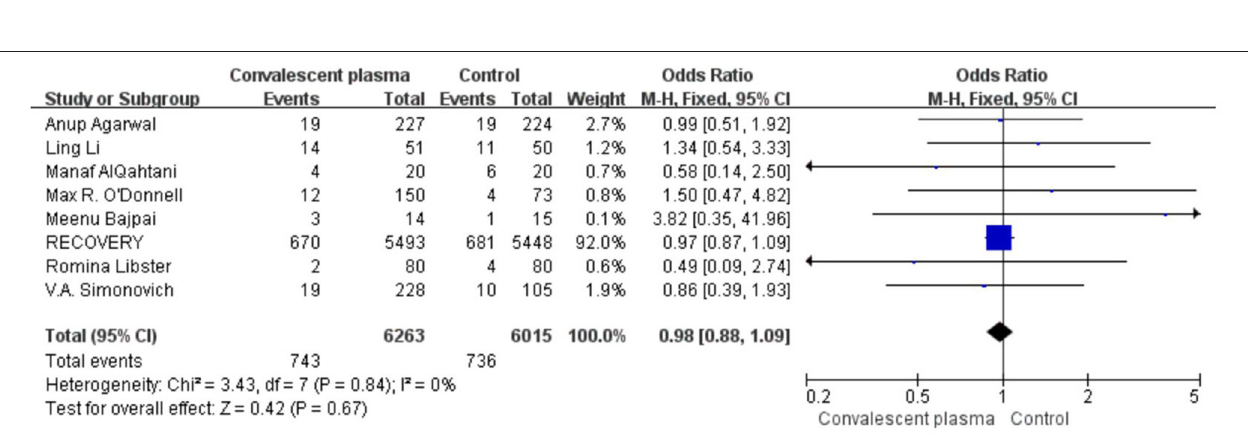
FIGURE 10 | Forest plot of the rate MV among patients treated with convalescent blood products and controls ( n = 8 studies). Weights are from fixed-effects analysis. CI, confidence interval; MV, mechanic ventilation.